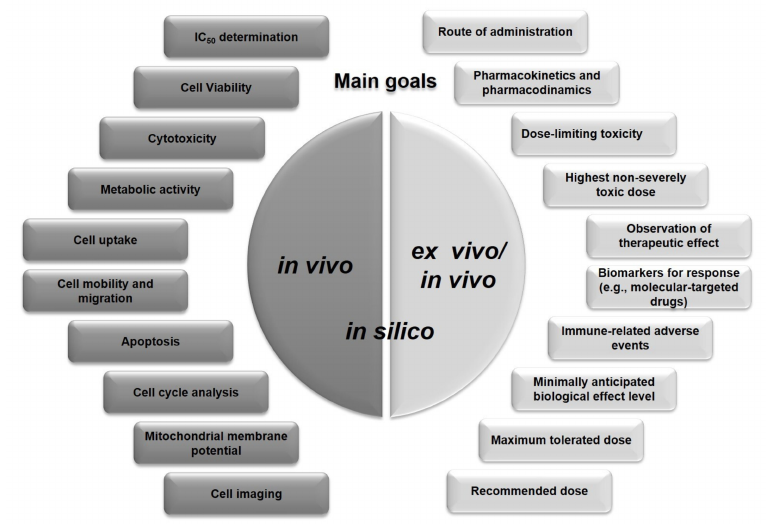
Figure 5. Main goals for using in silico, in vitro, ex vivo, and in vivo models for MNP